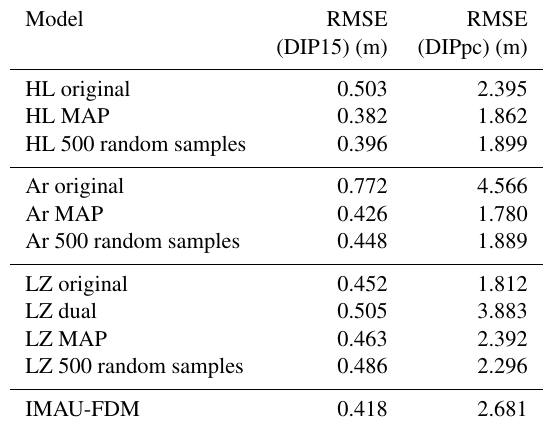
Table 2. Model results on the evaluation data. The root-mean- squared errors (RMSEs) are calculated with respect to the obser- vations of depth-integrated porosity until 15m depth and until pore